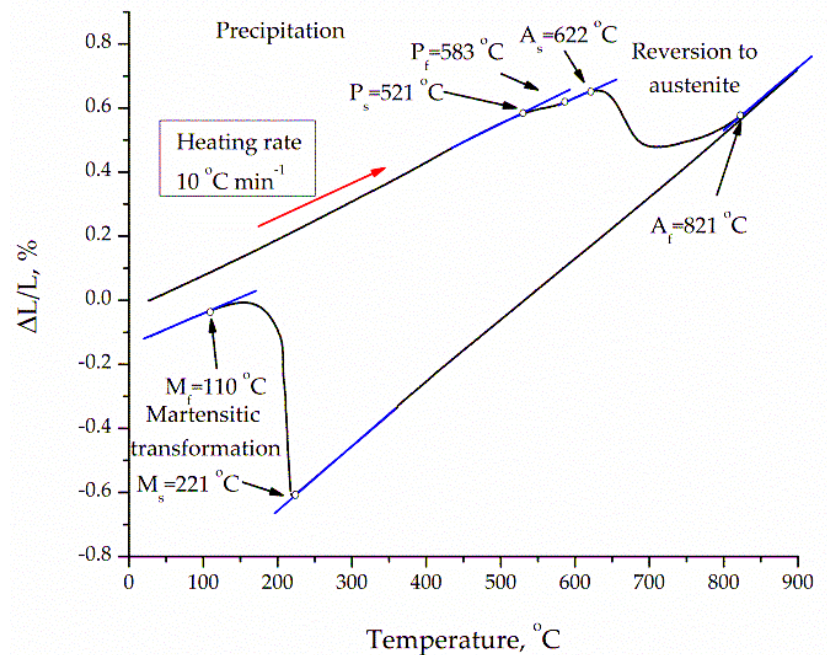
Figure 5. Variation in sample length at 10 °C/min for a SLM sample as a function of temperature [13].